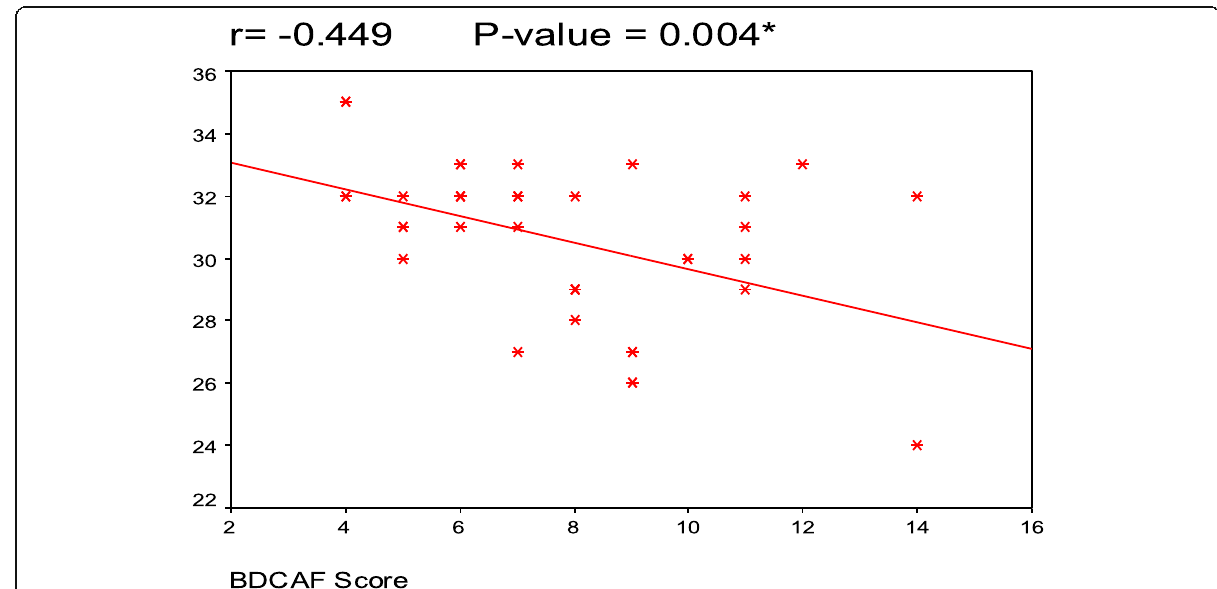
Fig. 2 Correlation between Behçet ’ s Disease Current Activity Form (BDCAF) score and left ventricular end-systolic